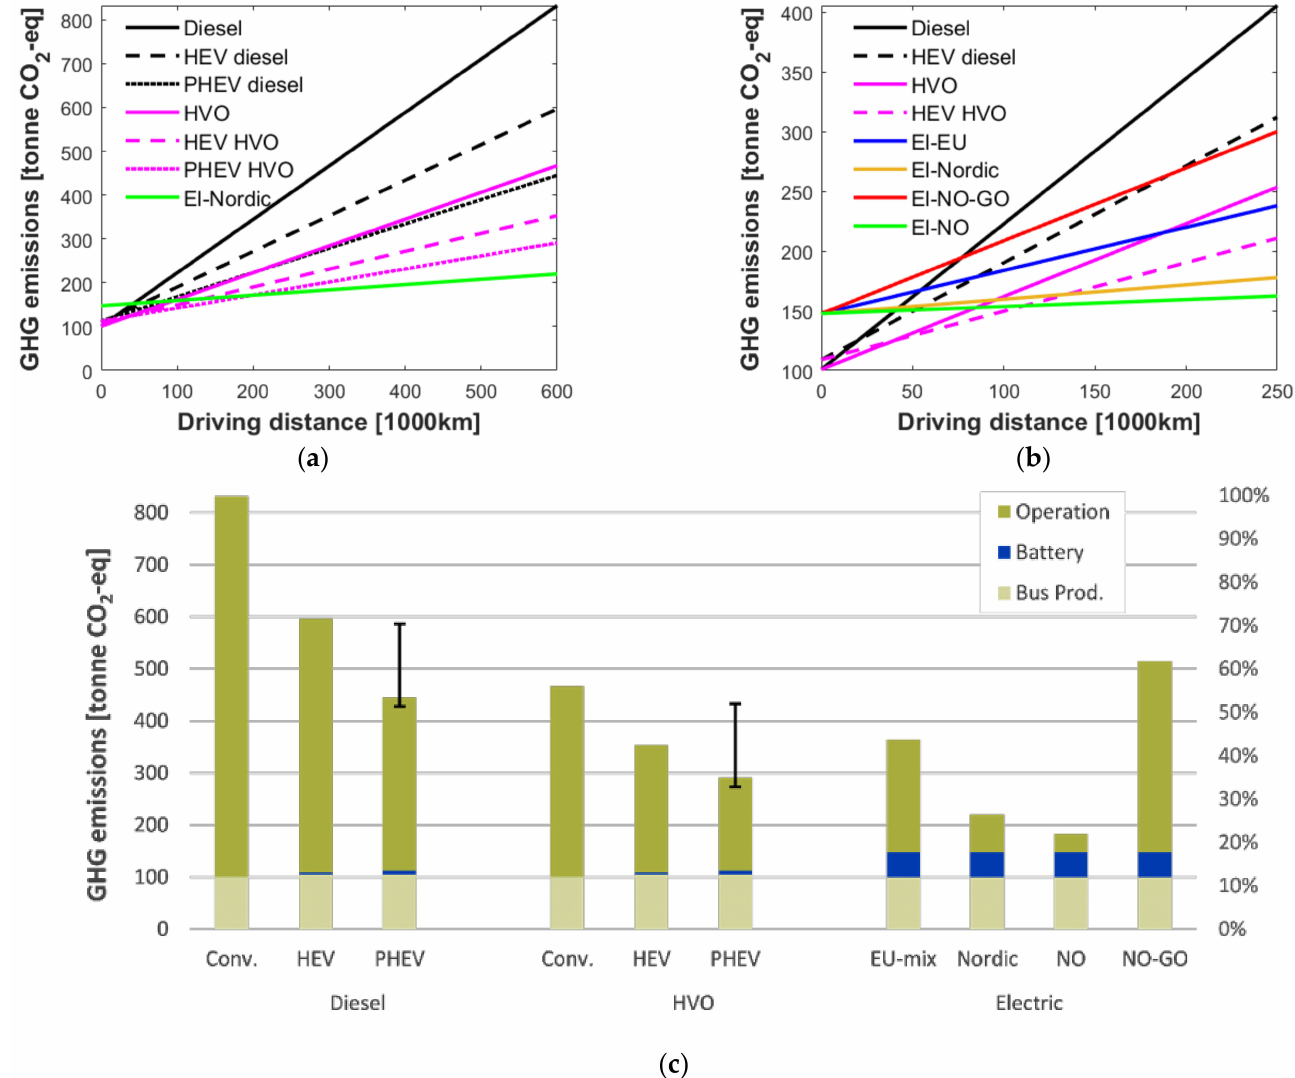
Figure 4. ( a ), GHG emissions versus driven distance for different fuel technologies (Nordic charging el-mix is used for the electrified options); ( b ), segment of 0–250,000 km for GHG emissions from the four simulations; and, ( c ), carbon footprint for the bus models. NO-GO represents charging with electricity in Norway without buying Guarantees of Origin (520 g CO 2 -eq/kWh). The error bars represent the range for the PHEVs from charging with a Norwegian el-mix as the lowest, and NO-GO el-mix as the